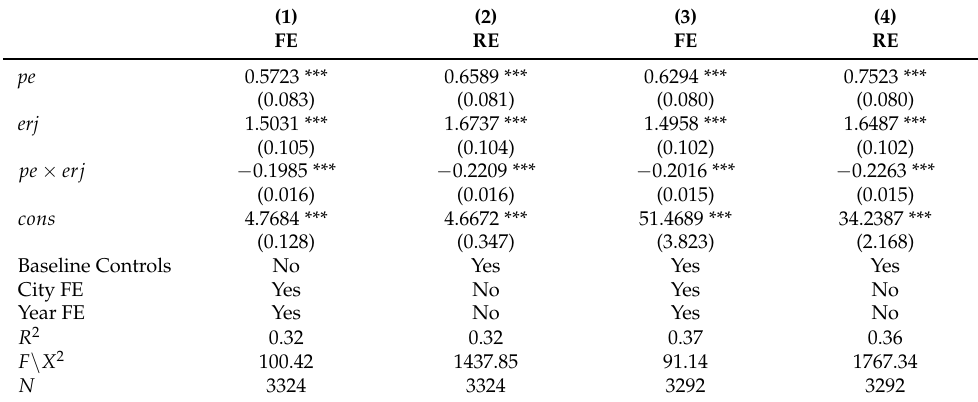
Table 8. Comprehensive analysis of energy input and allocation efficiency II.